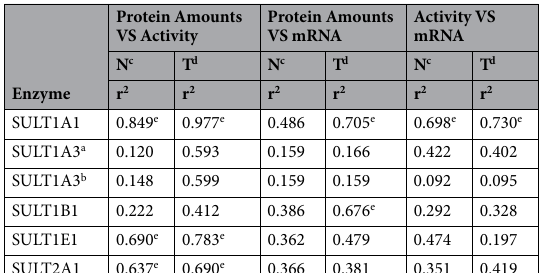
Table 4. Correlation of Enzyme Activity Protein to Protein Amounts and mRNA Expression Level of SULT Enzymes. a The metabolite is dopamine 3-O-Sulfate. b The metabolite is dopamine 4-O-Sulfate. c N: Pericarcinomatous. d T: Tumor. e Statistical significance of association (P < 0.05). r2 Pearson correlation